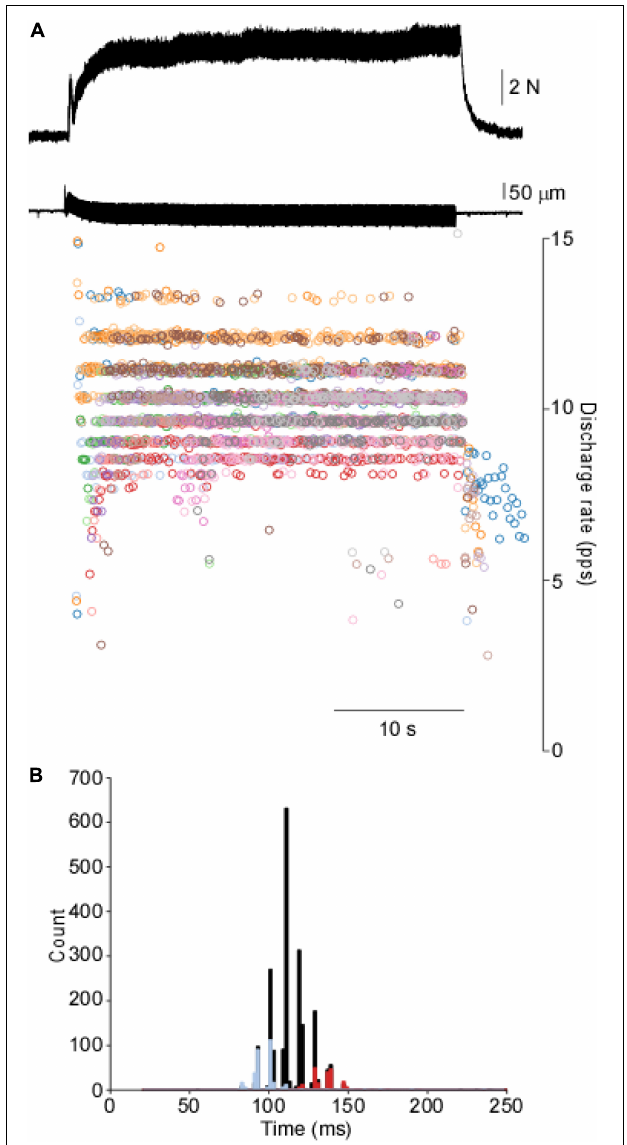
FIGURE 1 | Motor unit response to vibration in the cat’s soleus. (A) Tendon vibration of the soleus muscle produces motor output through the punctuated discharge of motor units. (B) . The cISI histogram reveals a highly punctuated discharge across a range of intervals. Two motor units are overlaid on top of the cISI histogram to demonstrate a single unit is relatively constrained further from the population